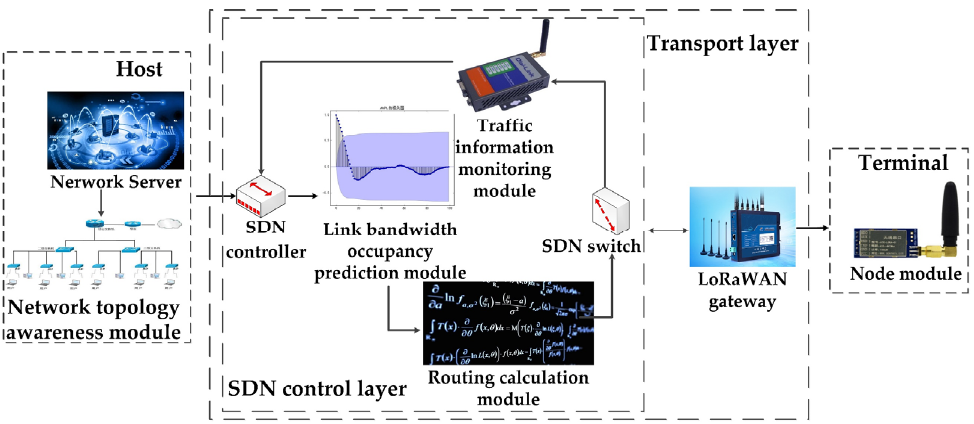
Figure 1. Gateway and server downlink communication protocol.